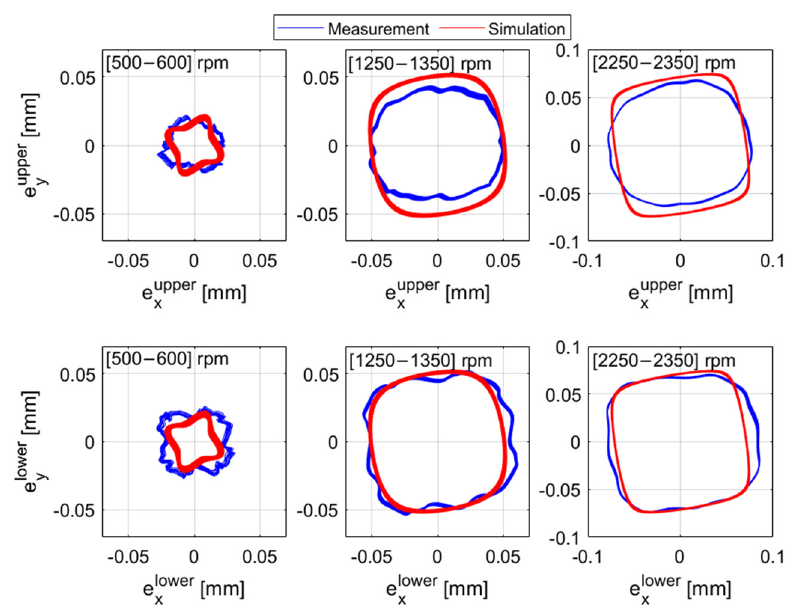
Figure 19. The simulated and measured orbit of the shaft with 5.9 × 10 − 3 kg · m unbalance magnitude and 2 π rad/s 2 angular acceleration.